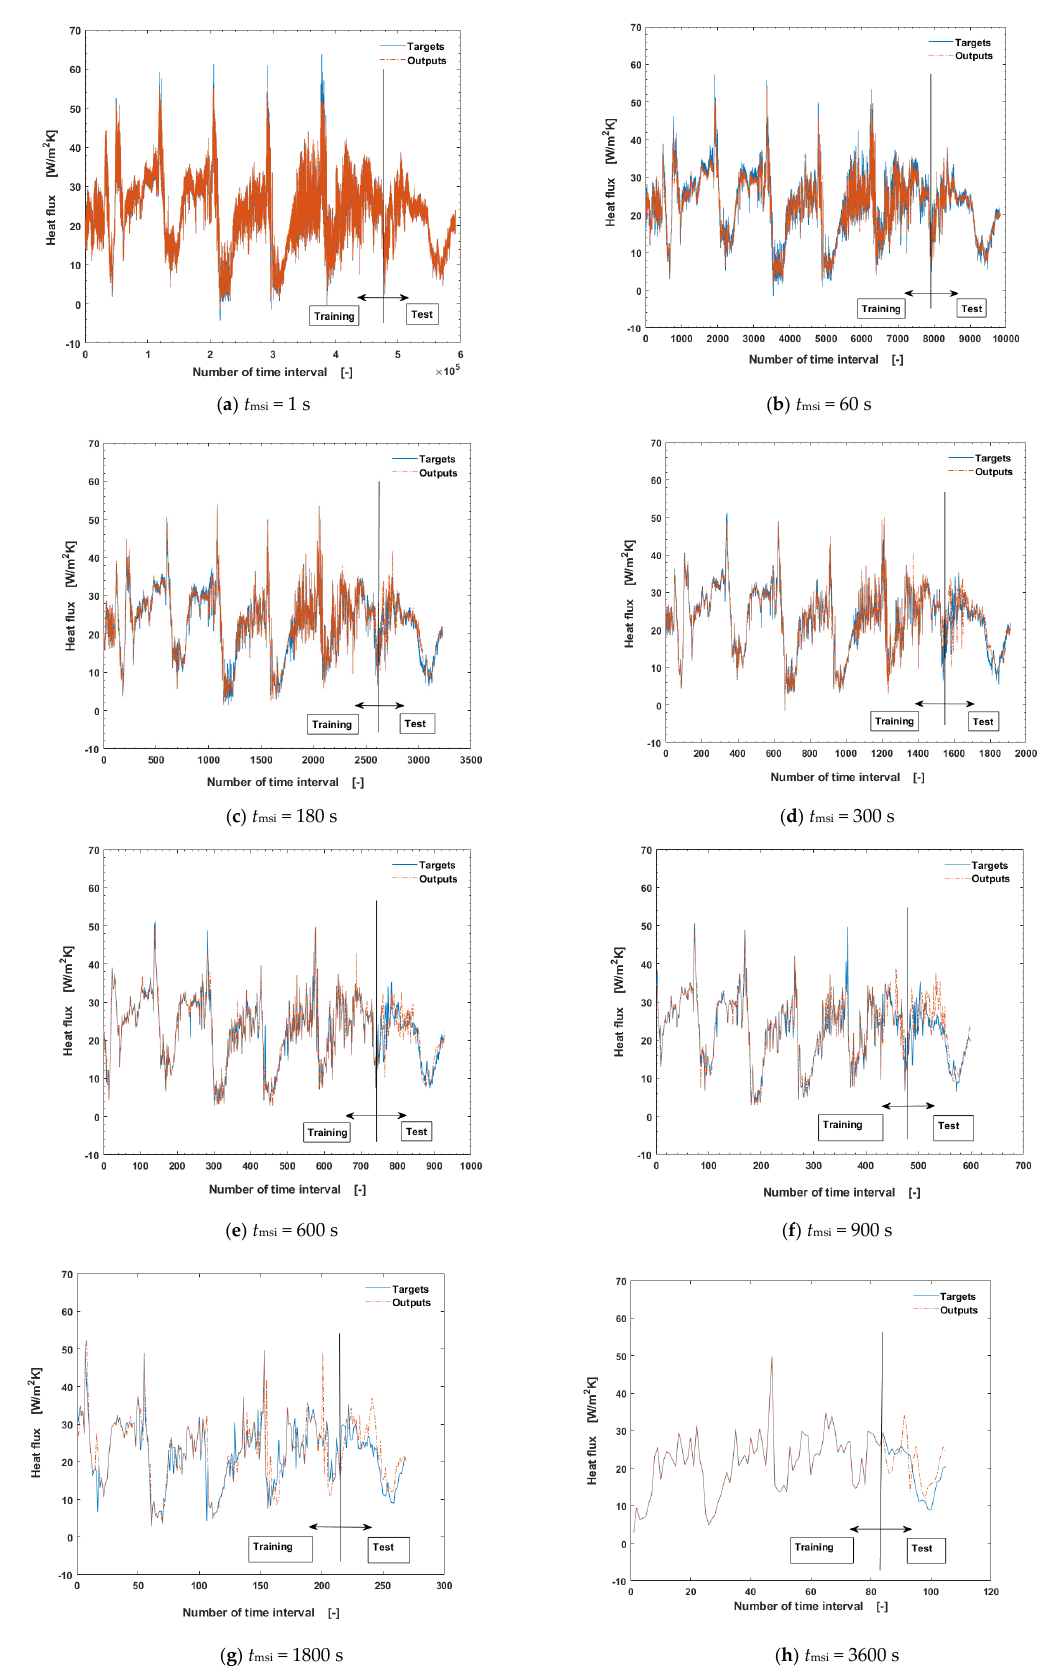
Figure 5. Evaluation of output graph for all data using LSTM model.